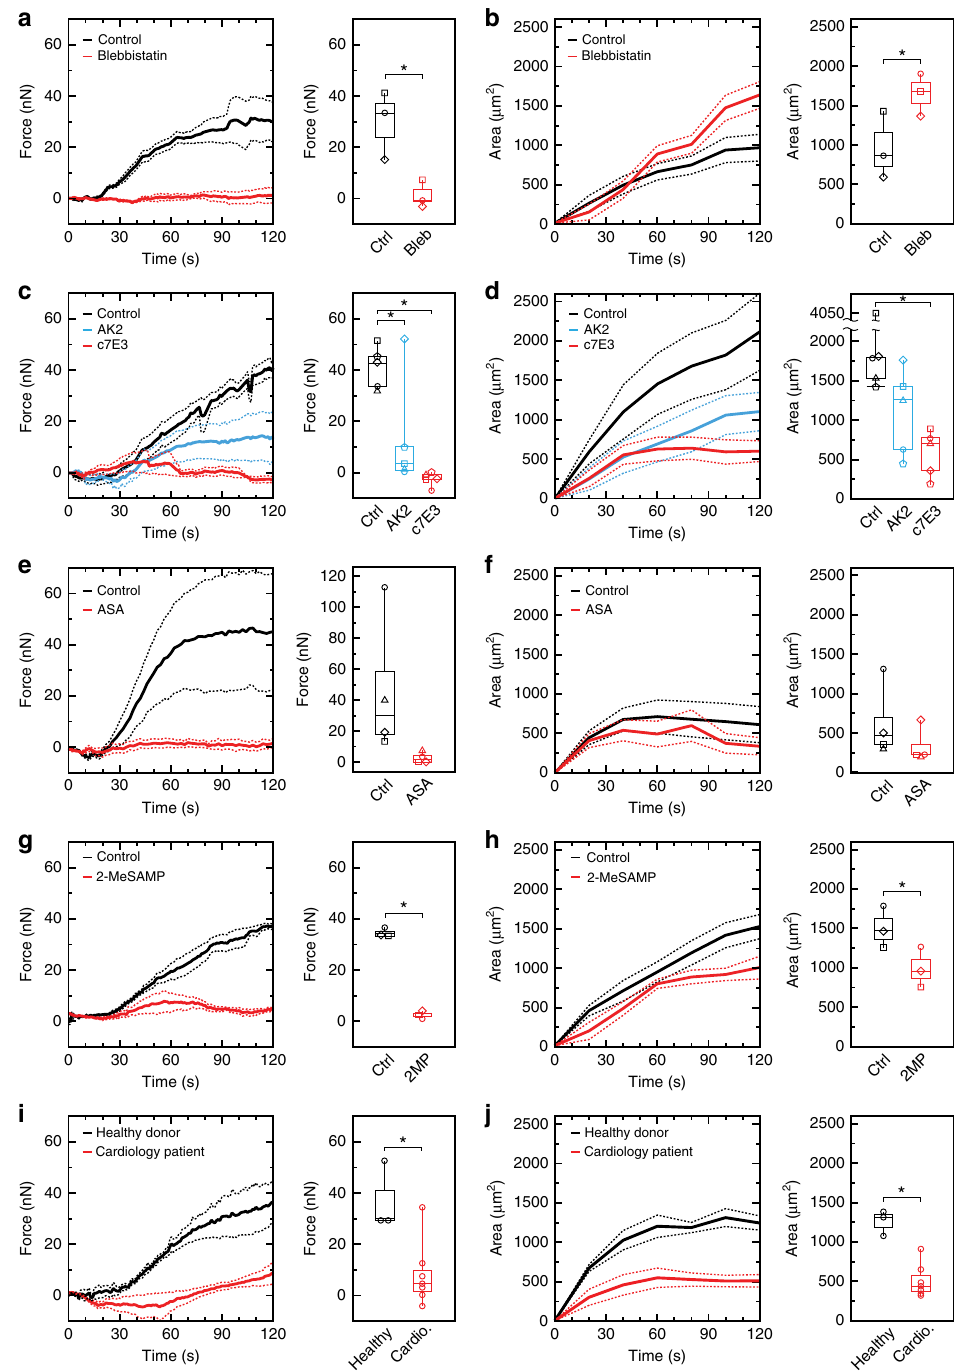
Fig. 3 Platelet forces are sensitive to platelet inhibition. Forces and projected areas are shown for measurements of aggregates in the micro fl uidic device. Myosin inhibition (5 μ M blebbistatin) causes a lower forces and b less compacted aggregates as compared to the control. Data are from three donors. Inhibition of GPIb-IX-V (5 μ g mL − 1 antibody AK2) or integrin α IIb β 3 (20 μ g mL − 1 antibody c7E3) causes a reduction in c platelet forces and d aggregate size. Data are from fi ve donors. Inhibition of thromboxane formation using 0.3 mM acetylsalicylic acid (ASA) reduces e platelet forces and f aggregate size. Data are from four donors. Inhibition of adenosine diphosphate (ADP) activation (10 μ M 2-MeSAMP (2-methylthioadenosine 5 ’ -monophosphate triethylammonium salt)) reduces g platelet forces and h aggregate size. Data are from three donors. Cardiology patients on aspirin therapy have signi fi cantly reduced i platelet forces and j aggregate size as compared to healthy donors. Data shown are from seven cardiology patients and three healthy donors. Solid lines indicate the mean and dashed lines indicate standard error of the mean. Body of the box plots represent fi rst and third quartiles. Center lines denote the median. Whiskers extend from the quartiles to the last data point within 1.5× interquartile range, with outliers beyond. Each marker shape in ( a – h ) represents control and inhibitor results for a blood sample from a single donor. Asterisks denote statistically signi fi cant differences (* p < 0.05) using paired two-way T -tests for ( a , b , e – h ), one-way analysis of variance (ANOVA) followed by Tukey ’ s post-hoc test for ( c , d ), and two-way unpaired T -tests for ( i , j